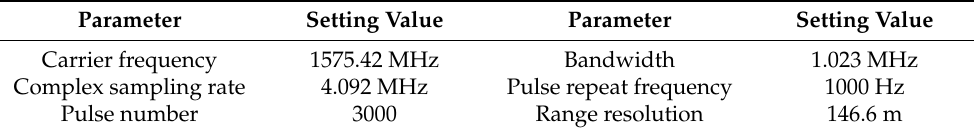
Table 1. Parameters of the radar system.